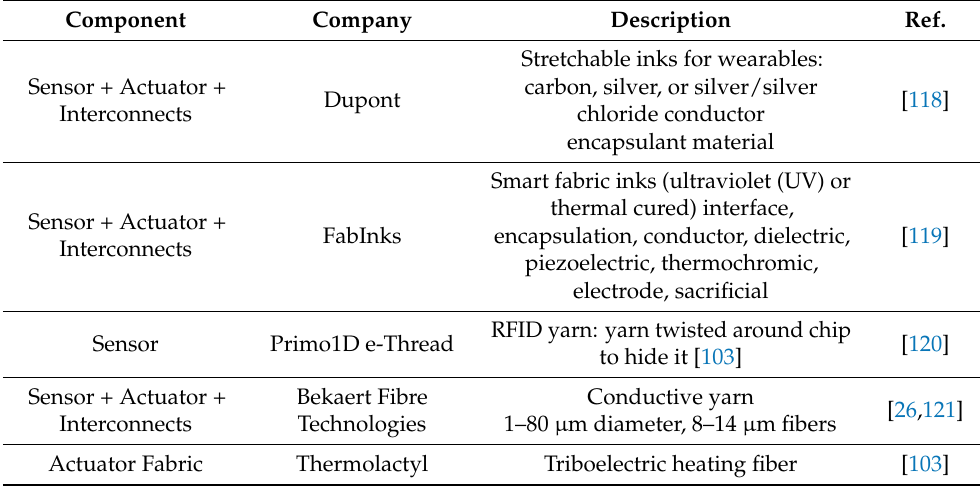
Table 4. Commercial materials for prototyping e-textiles. Component Company Description